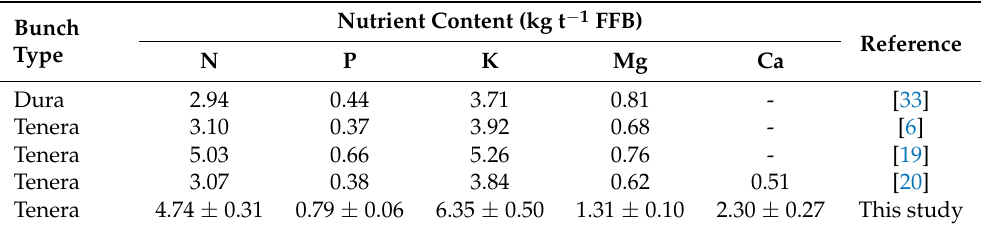
Table 9. Nutrient contents (mean ± SE) in dura and tenera fresh fruit bunches. Other studies did not report their SE